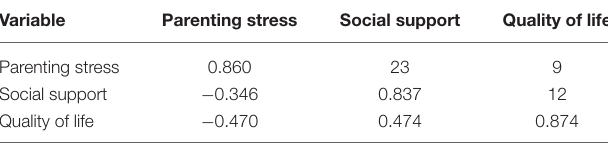
TABLE 5 | Pooled correlation matrix across studies.